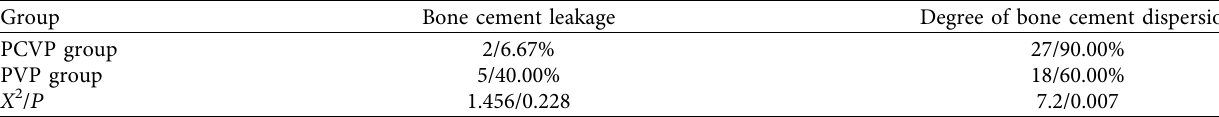
Table 4: Bone cement leakage and bone cement dispersion [cases